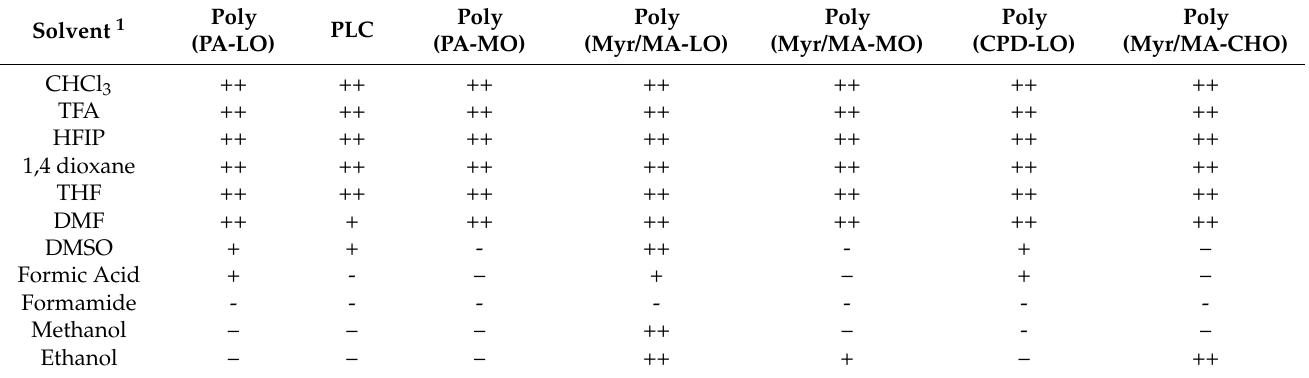
Table 1. Solubility of the selected terpene derivatives in common organic solvents.